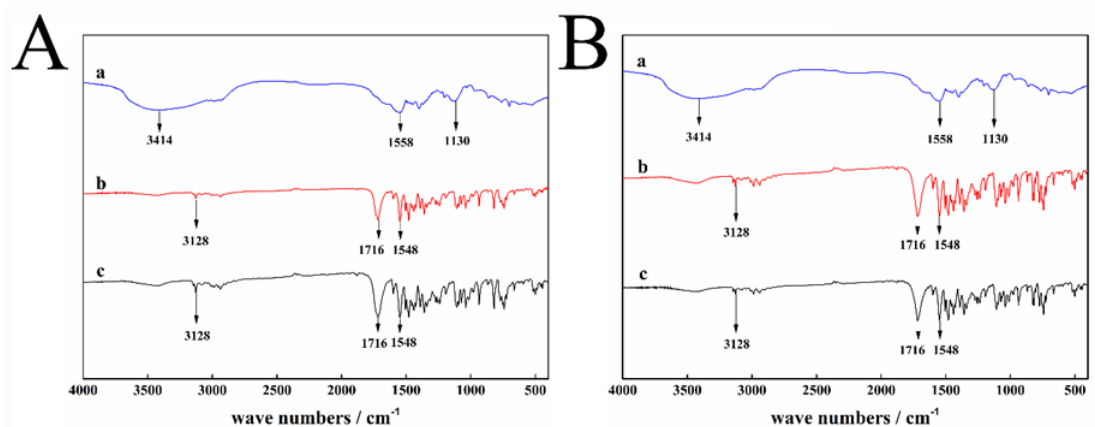
Figure 4. FTIR results of pyraclostrobin crystal II with or without adsorbed dispersant 2700: ( A - a ) 2700, ( A - b ) pyraclostrobin crystal II, ( A - c ) pyraclostrobin crystal II + 2700; pyraclostrobin crystal IV with or without adsorbed dispersant 2700: ( B - a ) 2700, ( B - b ) pyraclostrobin crystal IV, ( B - c ) pyraclostrobin crystal IV + 2700.